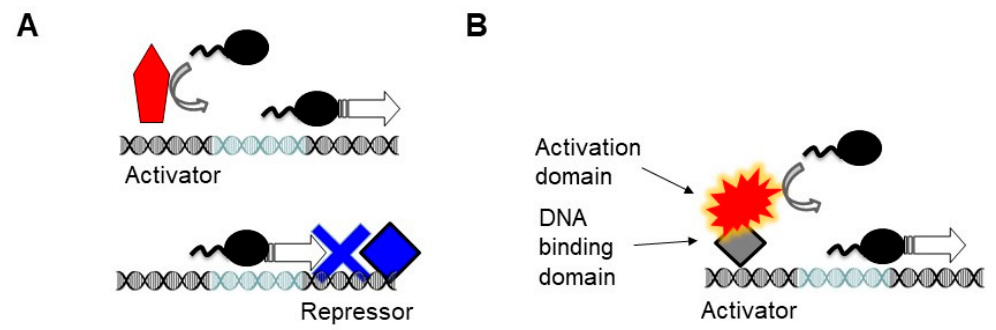
Figure 1. Modularity in the eukaryotic transcriptional regulation. The light blue segment of the DNA denotes the sequence recognized by the RNA polymerase (e.g., TATA box). ( A ) In prokaryotes, the RNA polymerase binds to the core promoter directly, which can be further enhanced by activators (red), which usually lack a separate activation domain. Prokaryotic repressors (blue) are simply DNA binding proteins, which act by blocking the binding of the polymerase along the DNA or its progression as a roadblock. Thus, they must bind at or downstream of the RNA polymerase binding sites. While the activator helps recruit the polymerase, the function of the repressor is solely to act as a DNA binding protein. ( B ) In eukaryotes, most activators have two domains. The DNA binding domains tether the activation domain to the DNA. The spiky shape denotes the tendency of the activation domains to have a disordered structure. Even a prokaryotic repressor can act as a DNA binding domain (gray diamond). Such modularly built activators are largely unknown in prokaryotes.